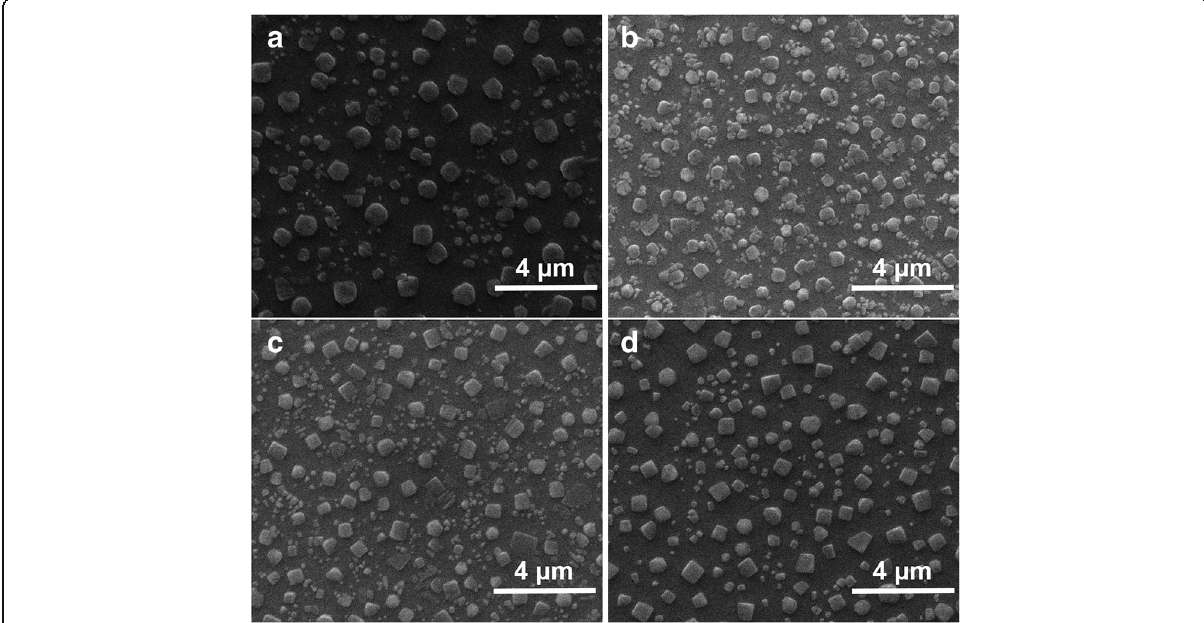
Fig. 6 Top-view SEM images of MAPbBr 3 films: a based on pristine PEDOT:PSS film and b – d based on PEDOT:PSS films treated with MeOH, EtOH, and IPA,